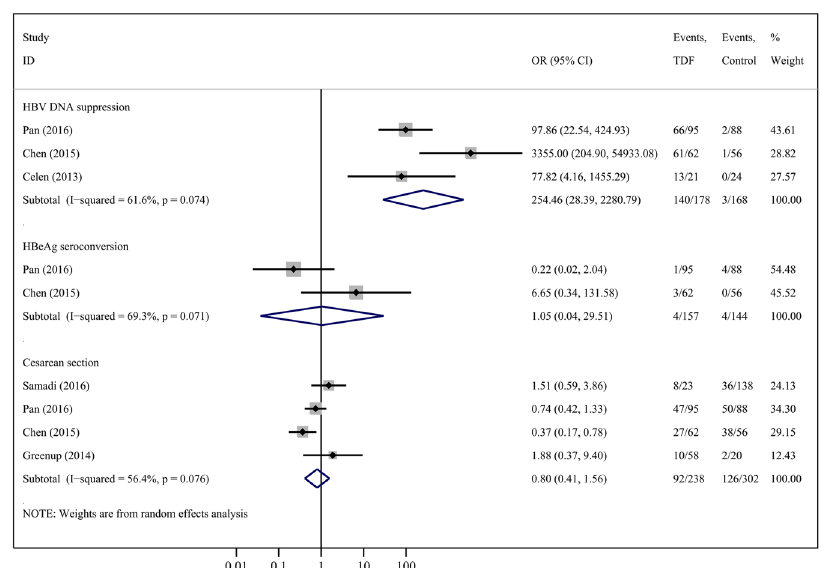
Figure 2. Forest plot showing meta-analysis of maternal outcomes for studies comparing TDF versus controls at delivery, based upon random-effects